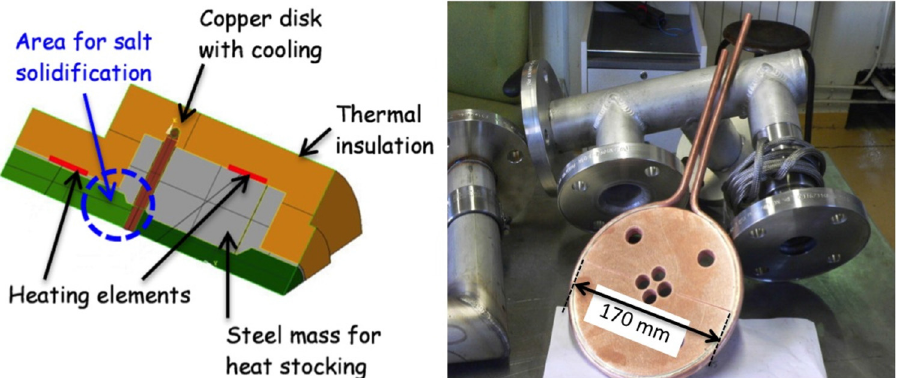
Fig. 2. Design of the fi rst cold plug used during FFFER experiments and details of the cooling copper piece before mounting and tests.